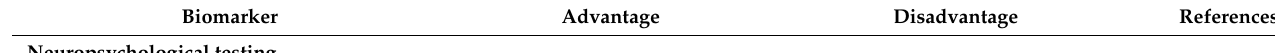
Table 2. Critical appraisal of different novel biomarking strategies for prodromal DLB with MCI